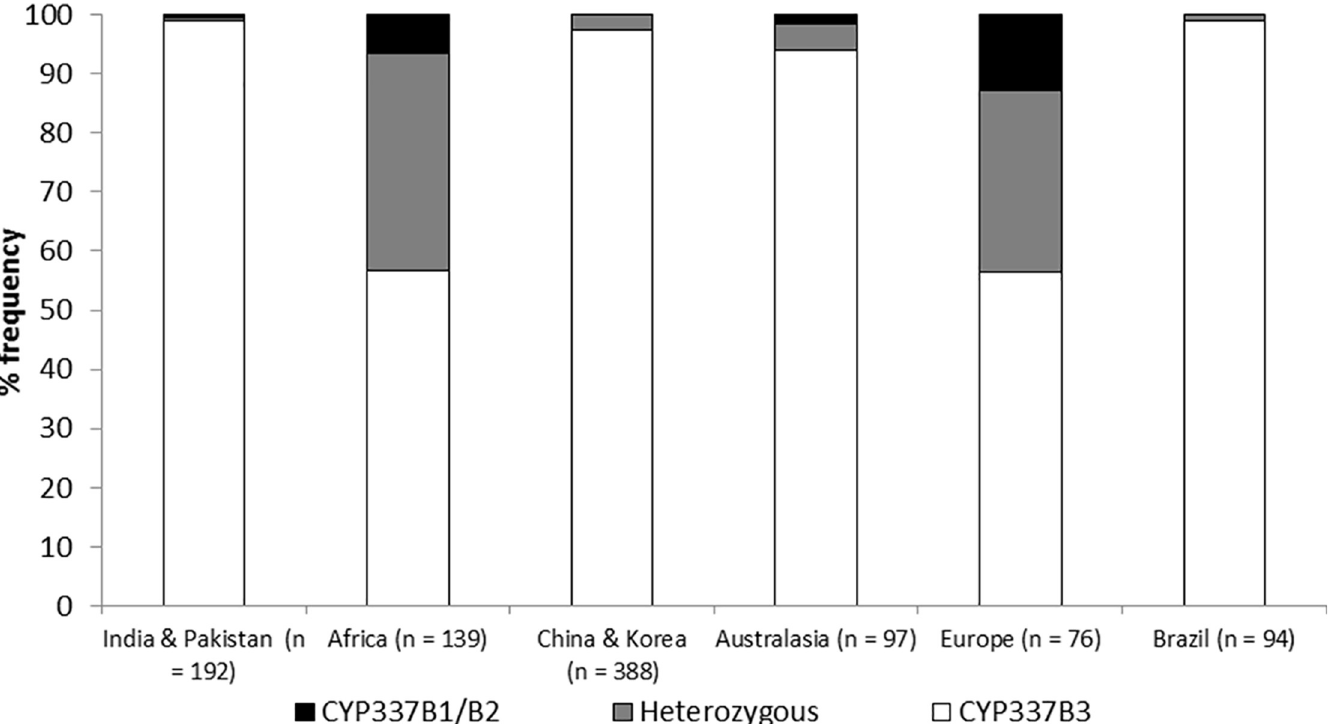
Fig 2. The frequency of CYP337B genotypes in selected geographic regions. For a more detailed breakdown see S1 Fig through S5 Fig.